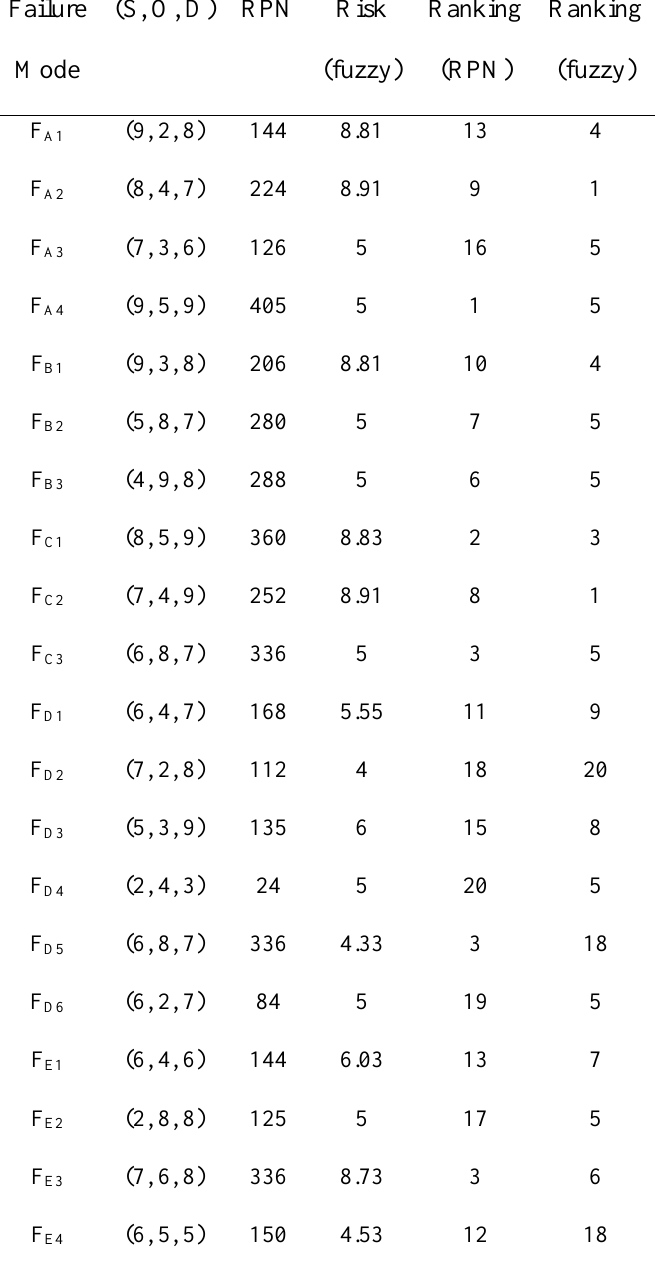
Table 4. The Results of Comparing Traditional FMEA with Fuzzy FMEA.